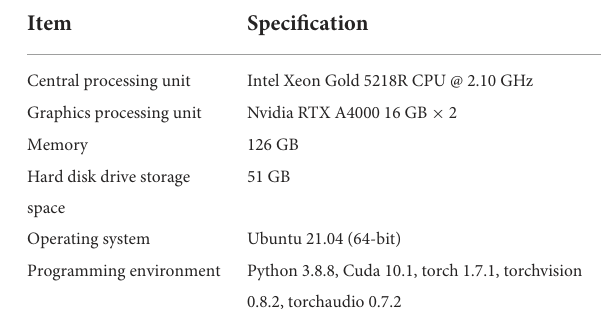
TABLE 1 Details of the experimental